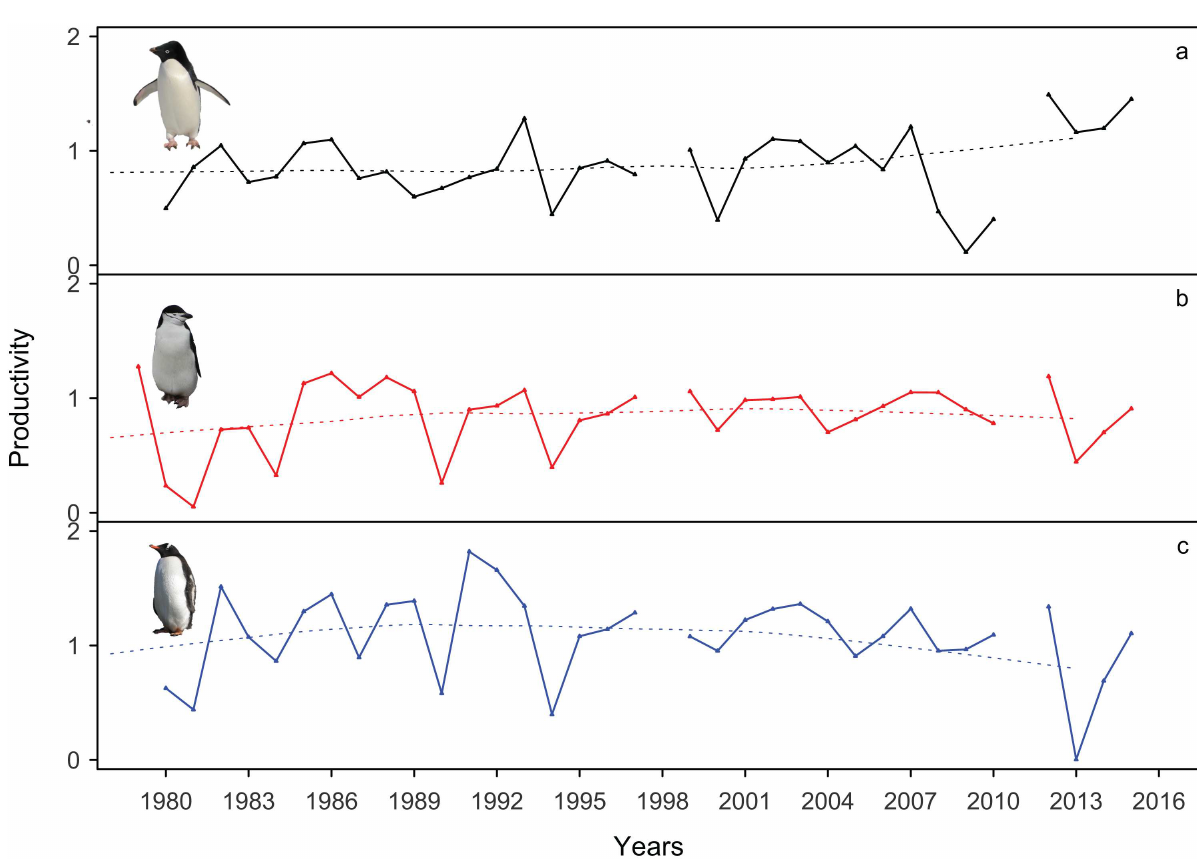
Fig 3. Annual penguin breeding successfrom 1978/79-2015/16 on Signy Island. Legend: the proportion of chicks fledged by breeding pairs (breedingproductivity) from (a) Ade´lie, (b) chinstrap and (c) gentoo colonies.Note this data includesthe entire island gentoo penguin population.Smooth trends (dashedlines) are plotted using least squares fitting of a first order polynomialfor each